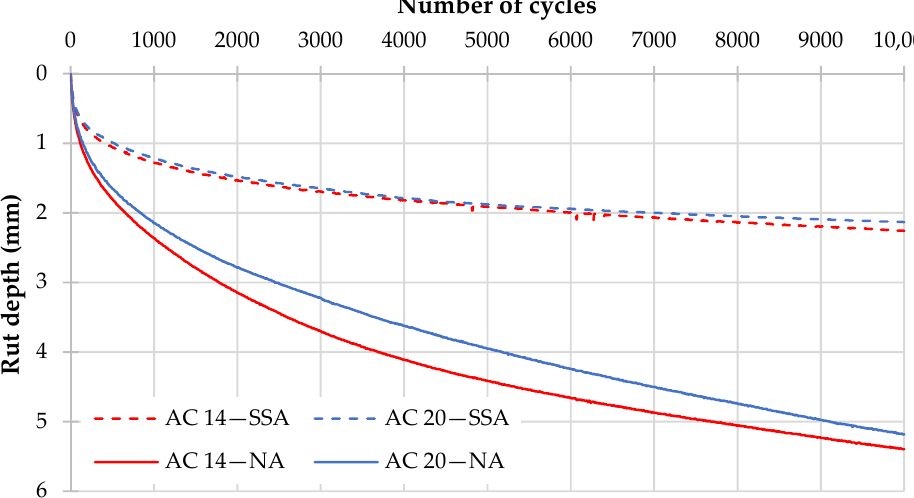
Figure 8. Evolution of the rut depth of the different asphalt mixtures in the WTT test.